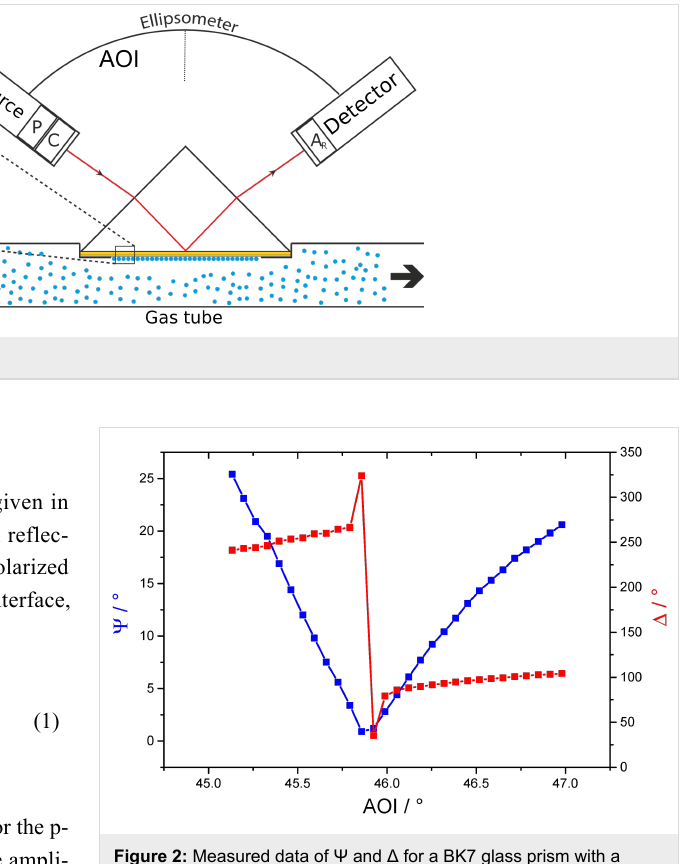
Figure 2: Measured data of Ψ and Δ for a BK7 glass prism with a 45 nm Au coating and a 5 nm SnO x add-on